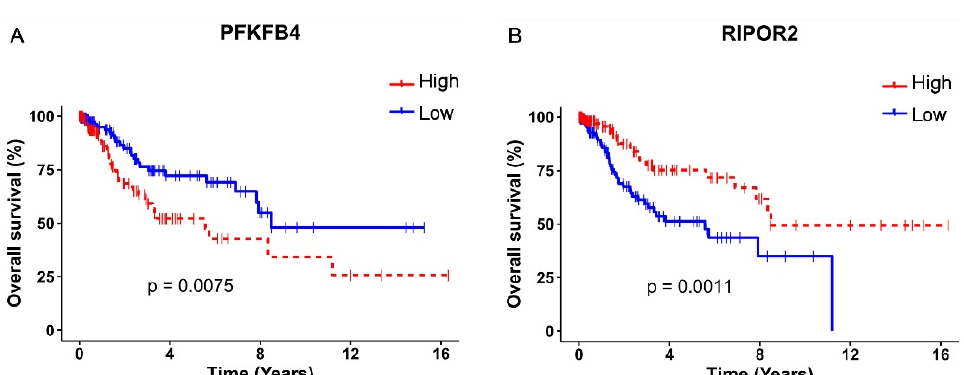
Figure 6. Kaplan–Meier OS analysis according to PFKFB4 and RIPOR2 expressions. Differences in OS of CC patients according to high or low expression of: ( A ) PFKFB4 ( p = 0.0075) and ( B ) RIPOR2 ( p = 0.0011). Low mRNA levels are represented with blue lines and high levels with red lines.